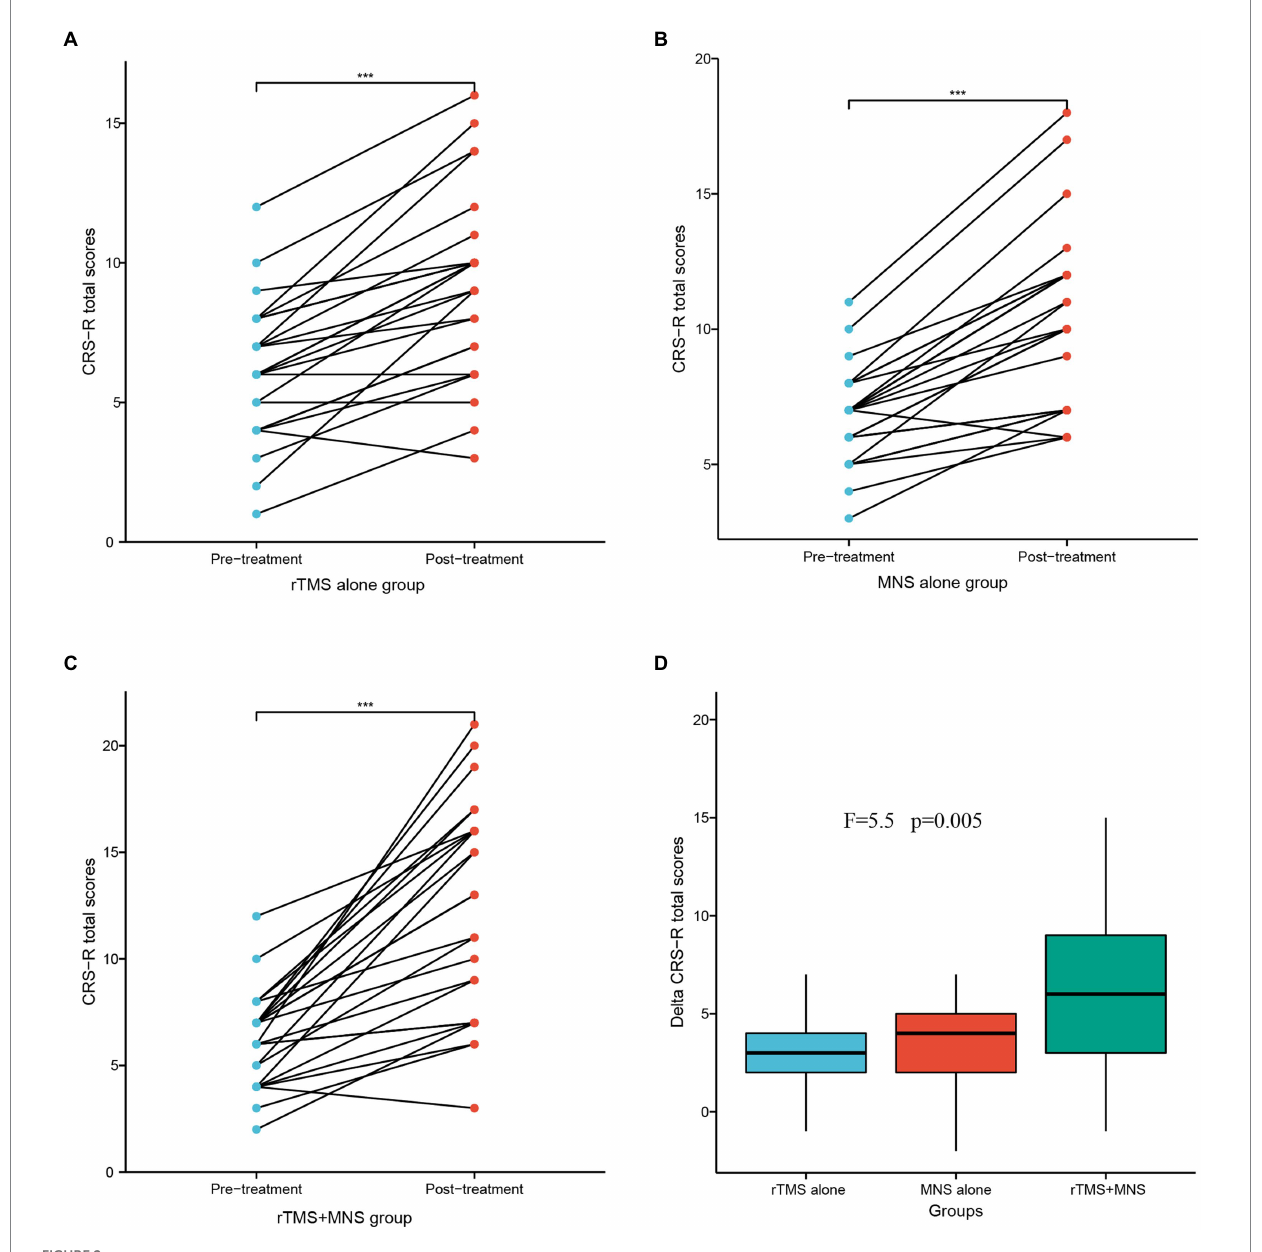
FIGURE 2 CRS-R total scores following 4 weeks of treatment for the rTMS alone, MNS alone and rTMS+MNS groups. A significant increase in the CRS-R scores compared with pre-treatment in the (A) rTMS alone, (B) MNS alone and (C) rTMS+MNS. (D) The changes in CRS-R scores between the three groups were statistically significant. ***means p <